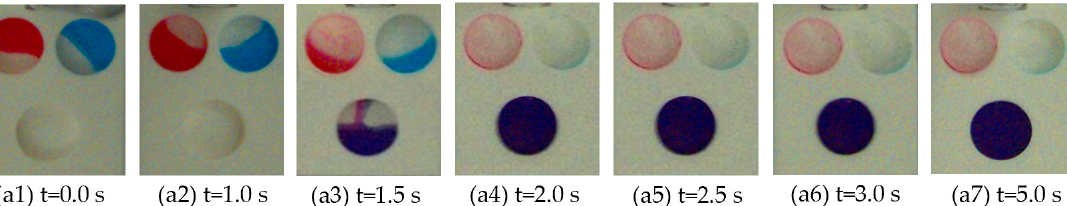
( a ) Photo images showing the mixing process for the Y-shaped mixer.